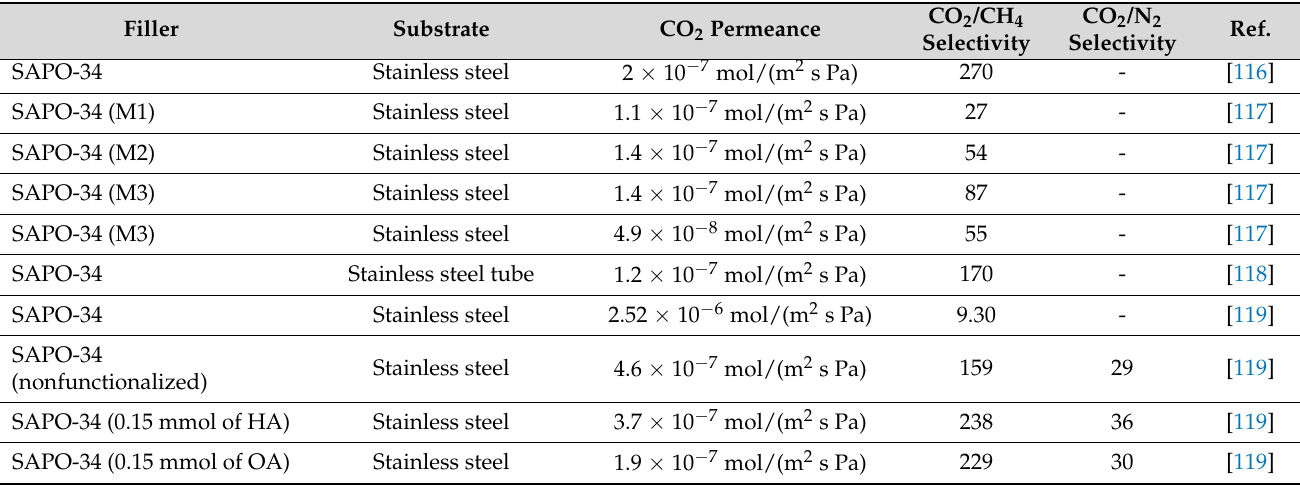
Table 2. Summary of separation performances for pure SAOP-34